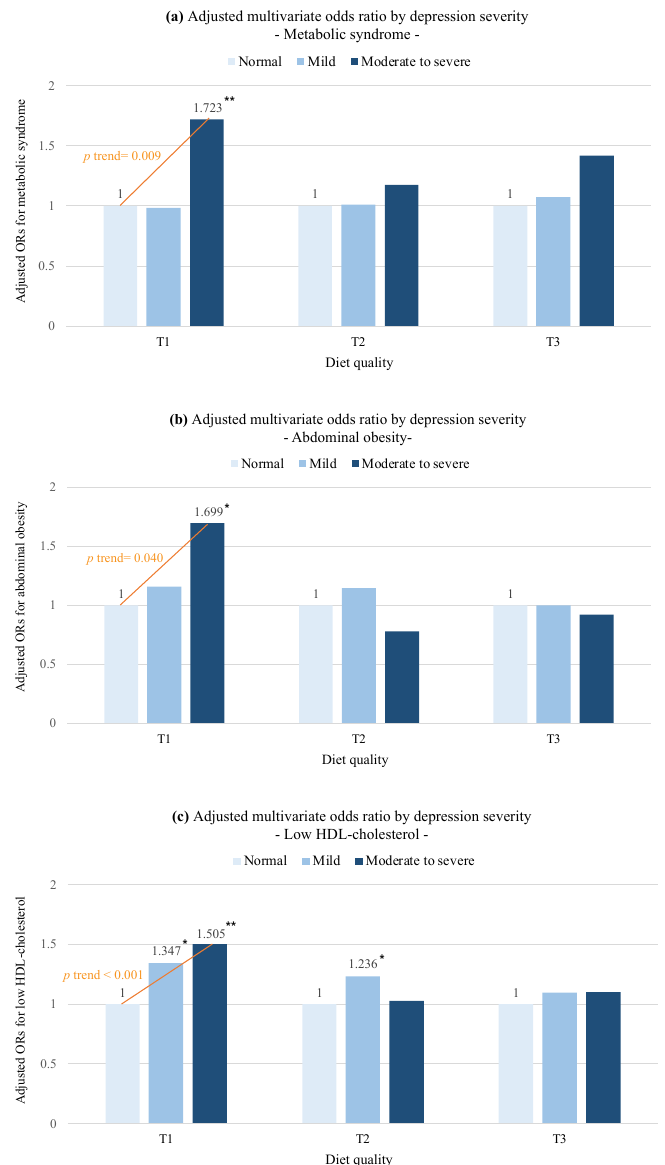
Figure 1. Adjusted odds ratios of metabolic syndrome ( a ), abdominal obesity (b ), and low HDL- cholesterol ( c ) according to depression severity after stratified by diet quality based on results of Table 5. The reference group was a normal group of each diet quality level. PHQ-9: Patient Health Questionnaire-9. PHQ-9 depression severity was divided by total scores of PHQ-9: normal, mild, moderate, to severe. KHEI: Korean Healthy Eating Index. Diet quality level was divided into tertiles by total scores of KHEI: Low (T1), Medium (T2), and High (T3). * p < 0.05, ** p < 0.01.